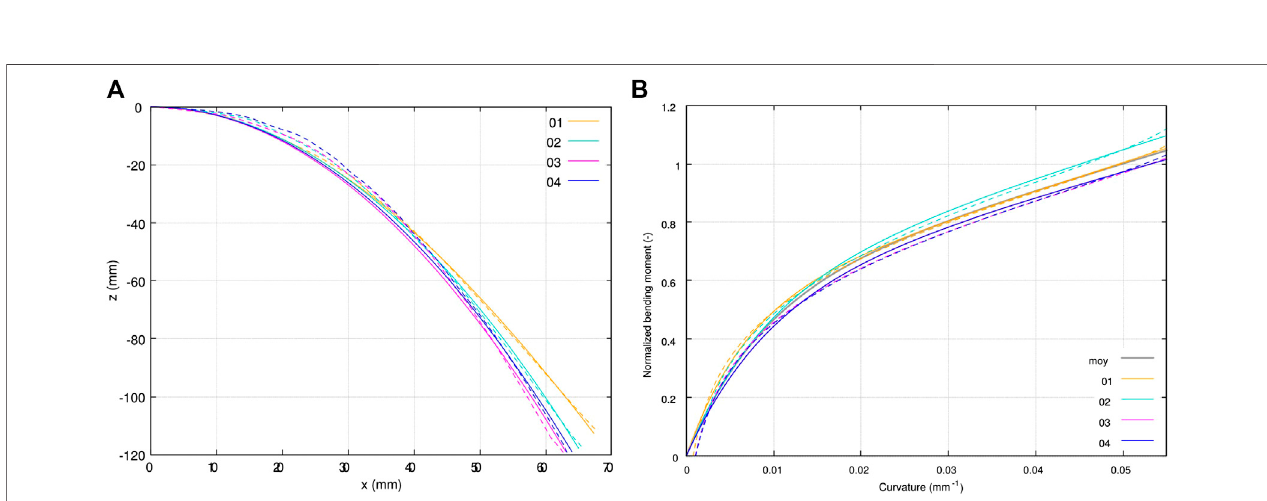
FIGURE 10 | Results of bending tests on single plies at T proc (experimental data in dashed line, optimized model in solid line): (A) deformed sample mean line with err ( z ) % < 2 . 5 % ,and (B) normalizedbendingmoment – curvaturerelationshipusingVoce ’ smodelwitherr ( M ) % < 3 % .Curves01to04correspondtosingletests;curvemoyis the average